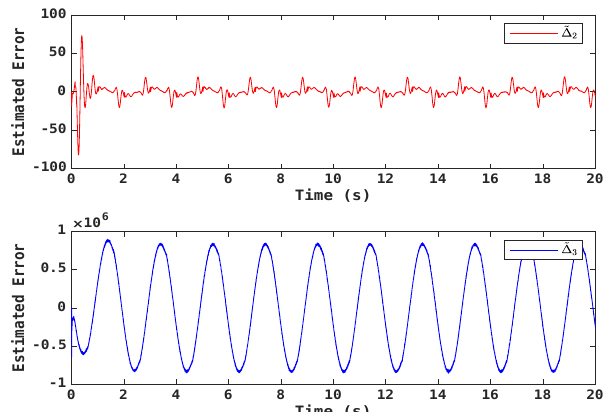
Figure 11. The estimated values of the VSDO in the experiment.